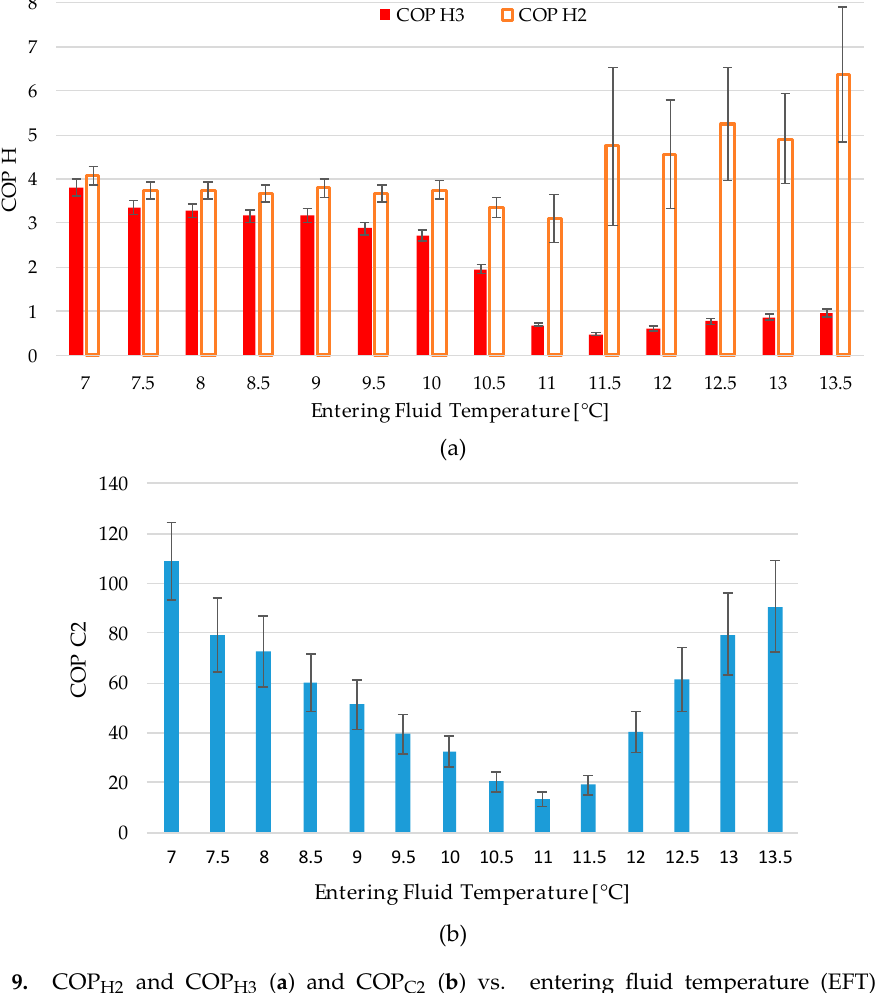
Figure 9. COP H2 and COP H3 ( a ) and COP C2 ( b ) vs. entering fluid temperature (EFT) with uncertainty bars.